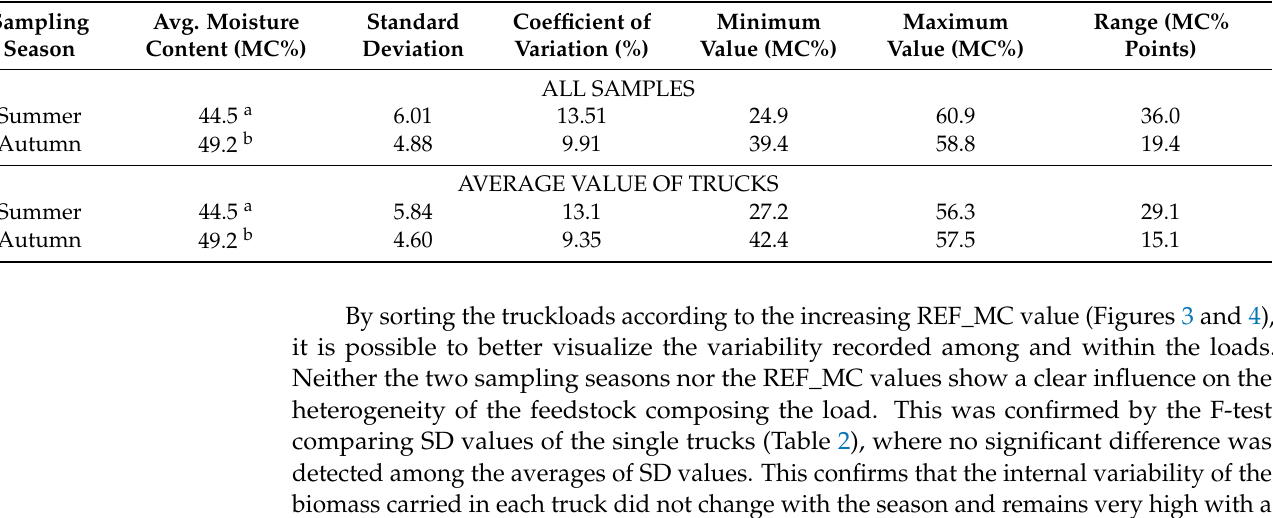
Table 1. Moisture content (MC) of all samples for the two seasons. Values in column with different letters (a and b) show a statistical difference with p -Value below 0.05.